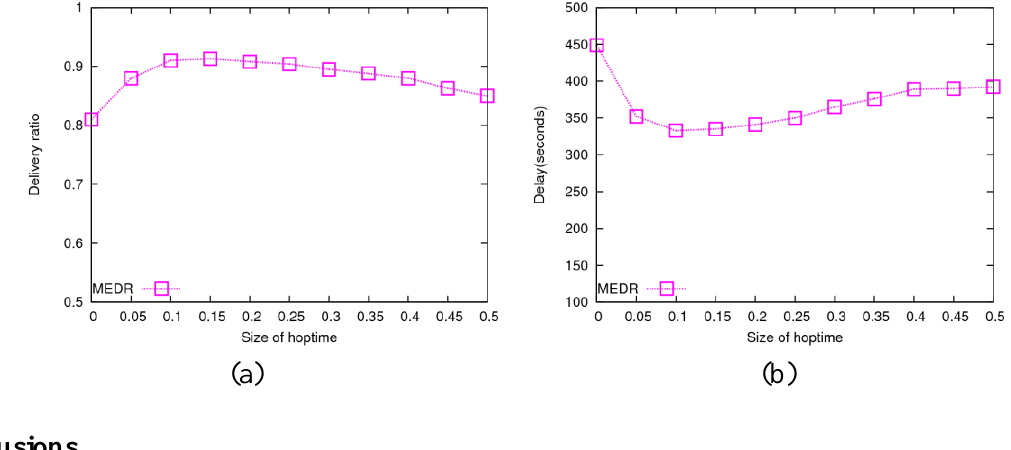
Figure 7. Impact of t in MEDR. (a) Average delivery ratio; (b) Average hop